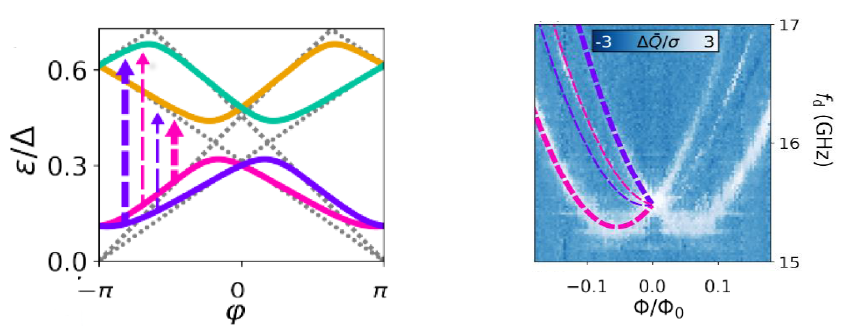
Figure 13: (from Ref. [ 37 ] ) Left panel: a sketch of the Andreev levels dispersion with ϕ in a single-mode highly transparent junction. Its length is assumed to some- what exceed the superconducting coherence length, allowing for two Andreev levels. The level degeneracy at ϕ = 0 is the manifestation of time-reversal symmetry; the degeneracy at ϕ = ± π is due to the symmetry with respect to the product of time re- versal and spatial inversion transformations. At other values of ϕ , Kramers doublets are split due to the combination of a finite Josephson current and present spin-orbit coupling. Various dashed arrows indicate transitions involving promotion of a quasi- particle from a lower to higher-energy Andreev state. Right panel: spectroscopic lines corresponding to the indicated transitions. The lines intersection at Φ / Φ reflects the ϕ = 0 Kramers